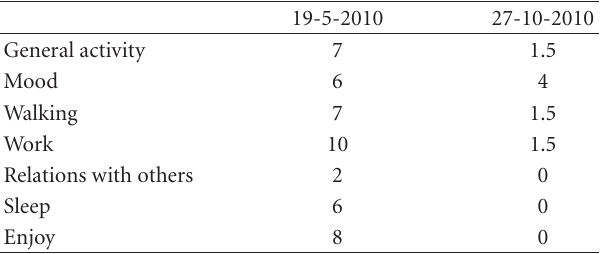
Table 1: Interference of pain in patient’s